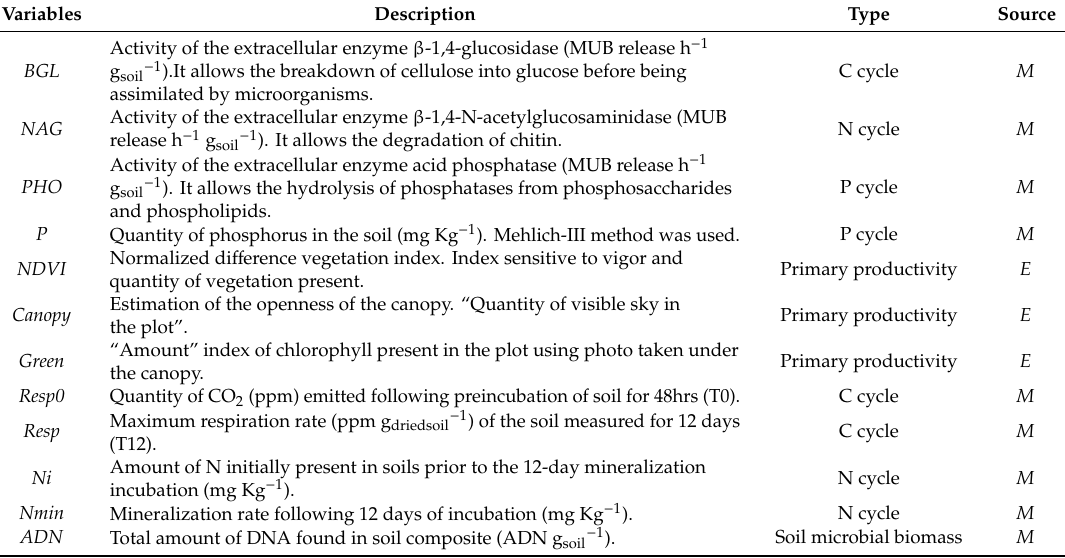
Table 2. Description of ecosystem functioning